Question: According to this chart, does the measure grow or shrink?
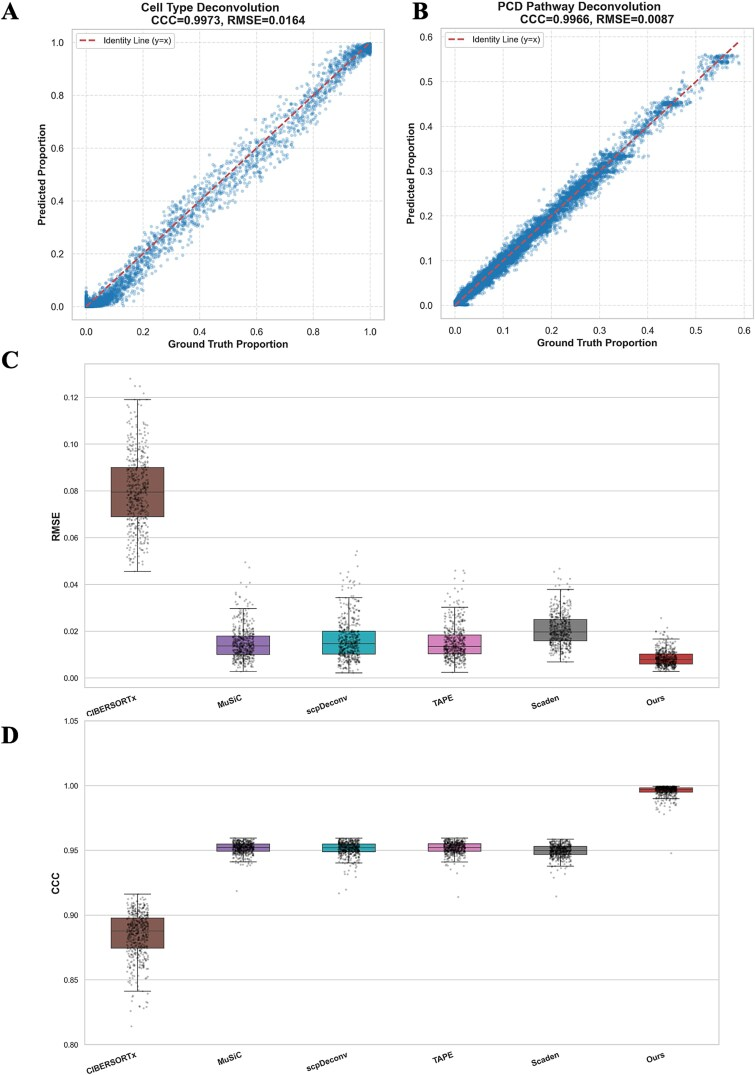
Answer: increasing